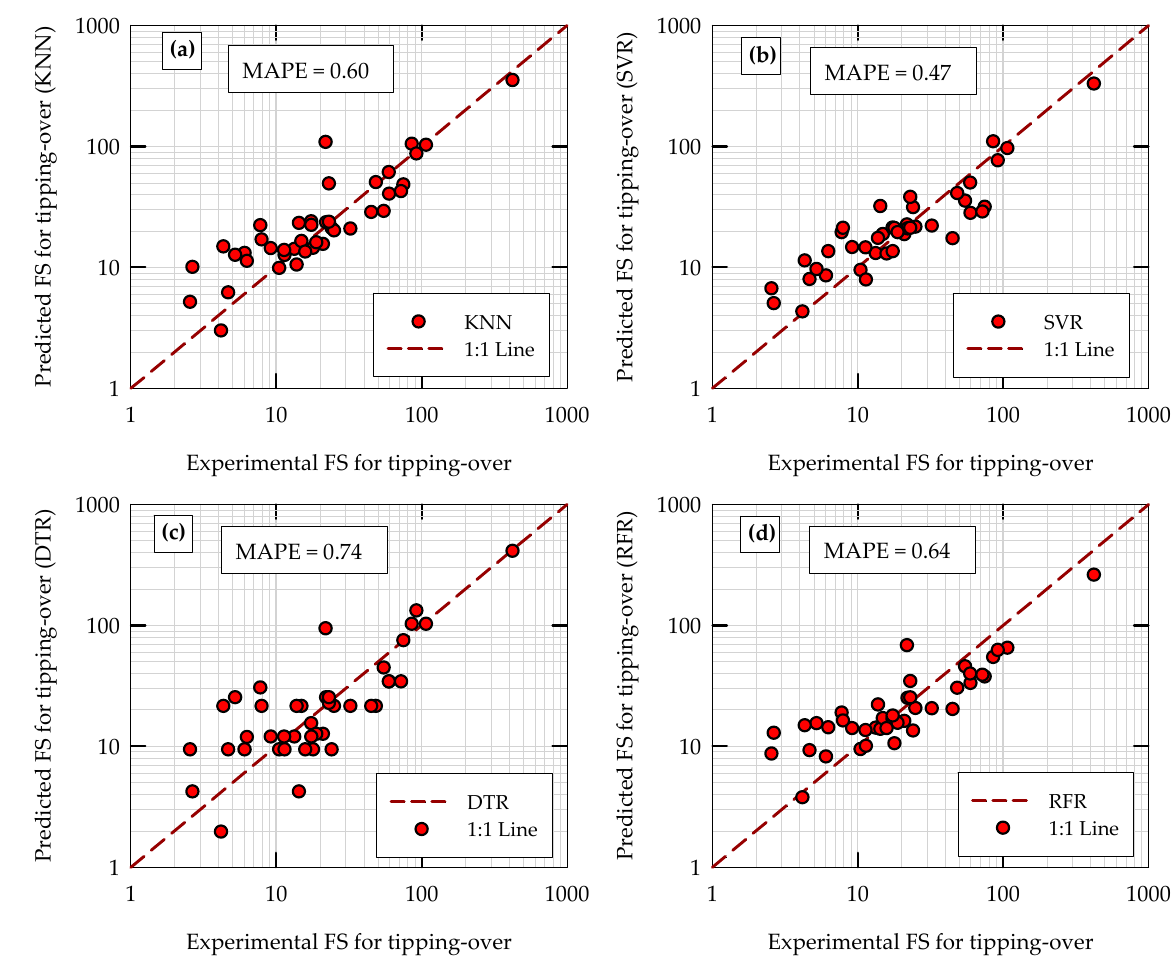
Figure 8. Comparisons of machine learning model predictions with experimental results for factor of safety for tipping over of rocking foundations during initial testing phase of models: ( a ) KNN model (with k = 3), ( b ) SVR model (with C = 20 and ε = 0.1), ( c ) DTR model (with maximum depth = 6), ( d ) RFR model (with number of trees = 100).